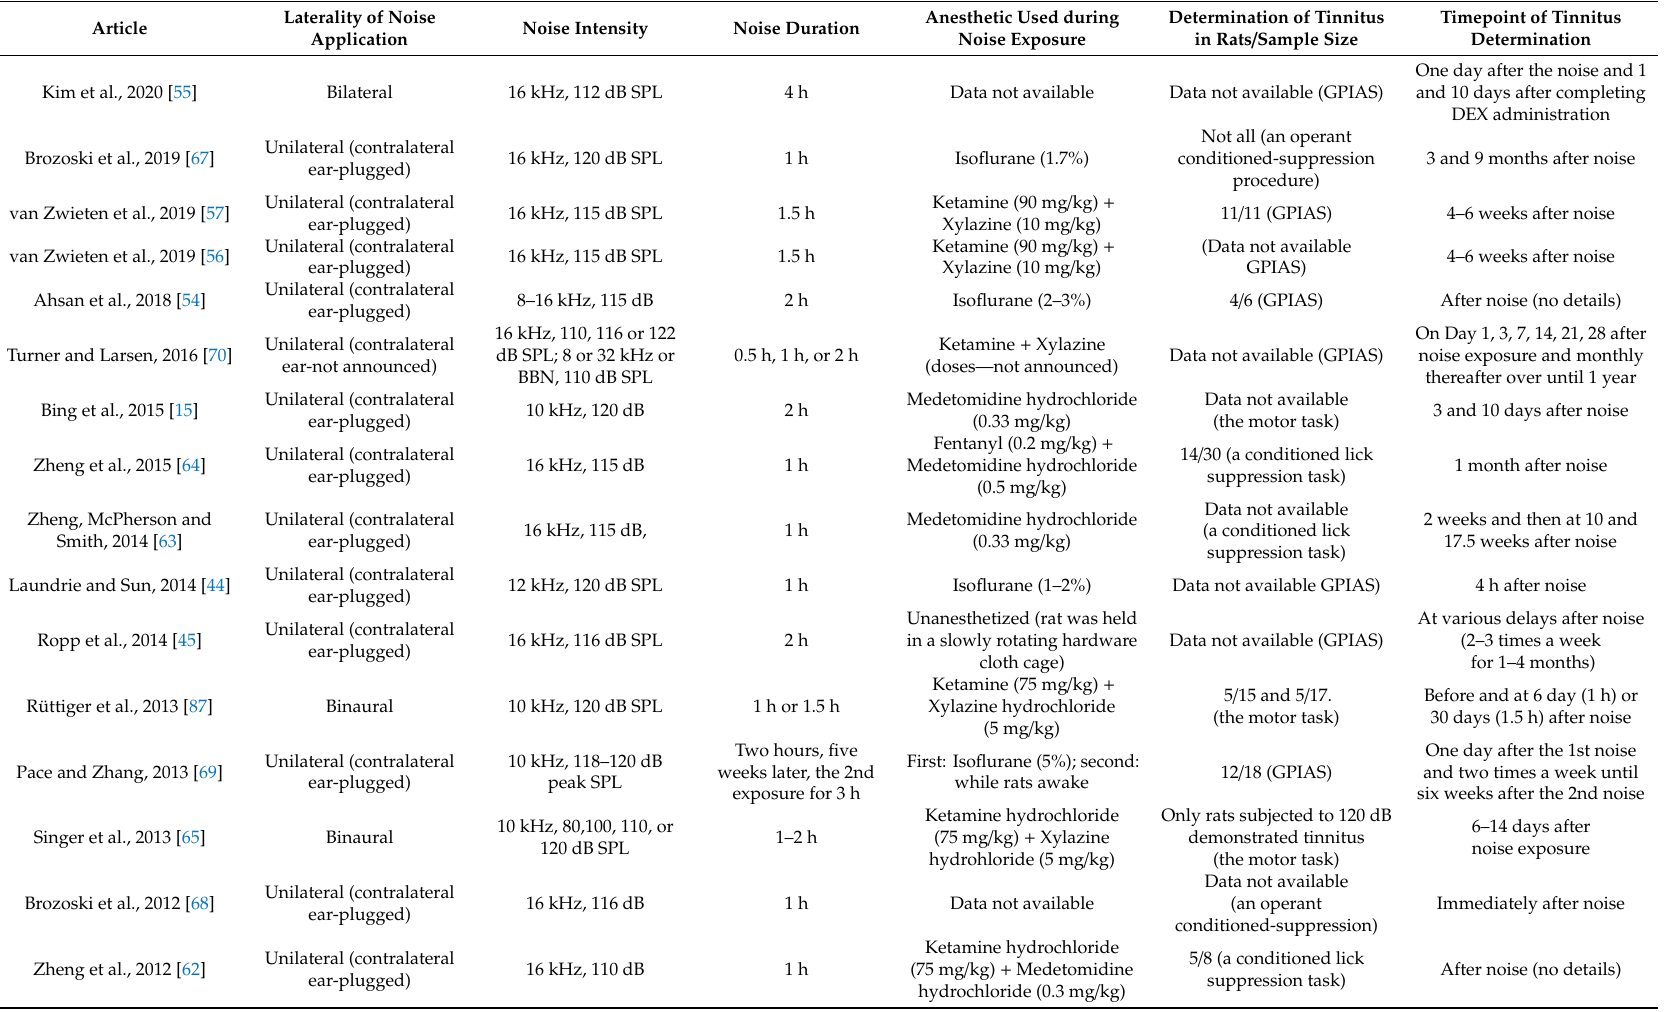
Table 3. Features of experiments with noise-induced